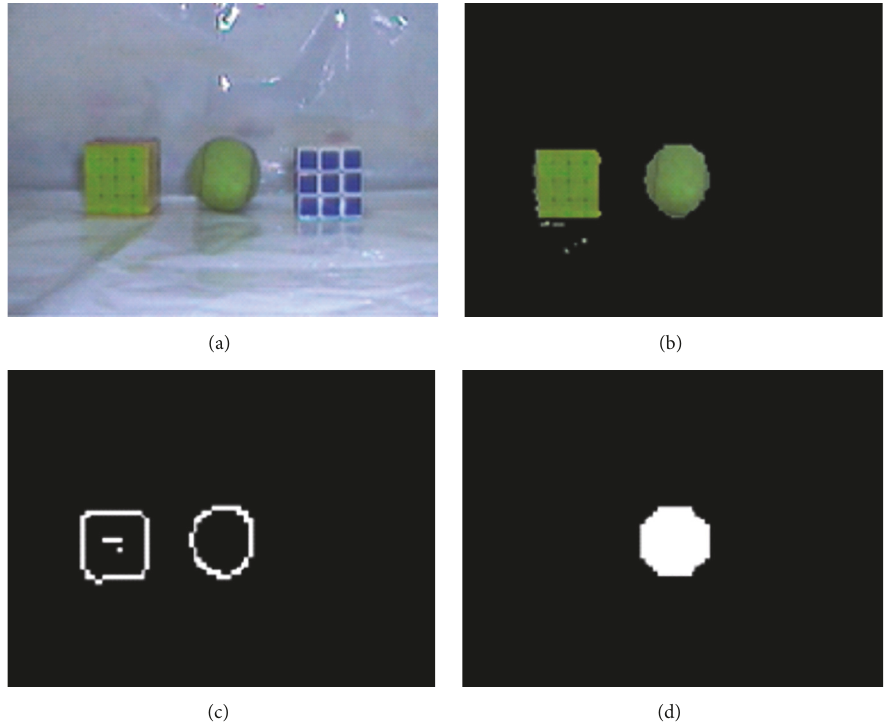
Figure 8: (a) Objects with different color and different shape, (b) effect diagram of green target extraction, (c) targets with different shapes circle target after Canny edge detection, and (d) effect diagram of detection by Hough circle